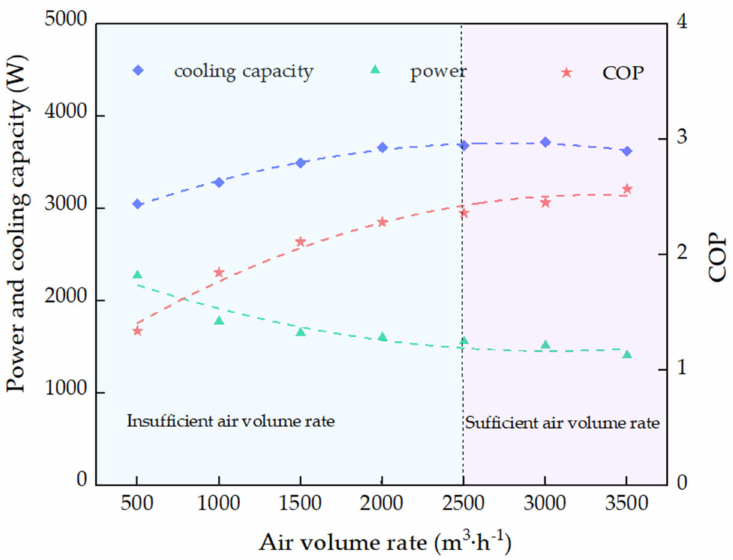
Figure 5. Effect of the air volume flow rate in the gas cooler on the compressor power input, cooling capacity and